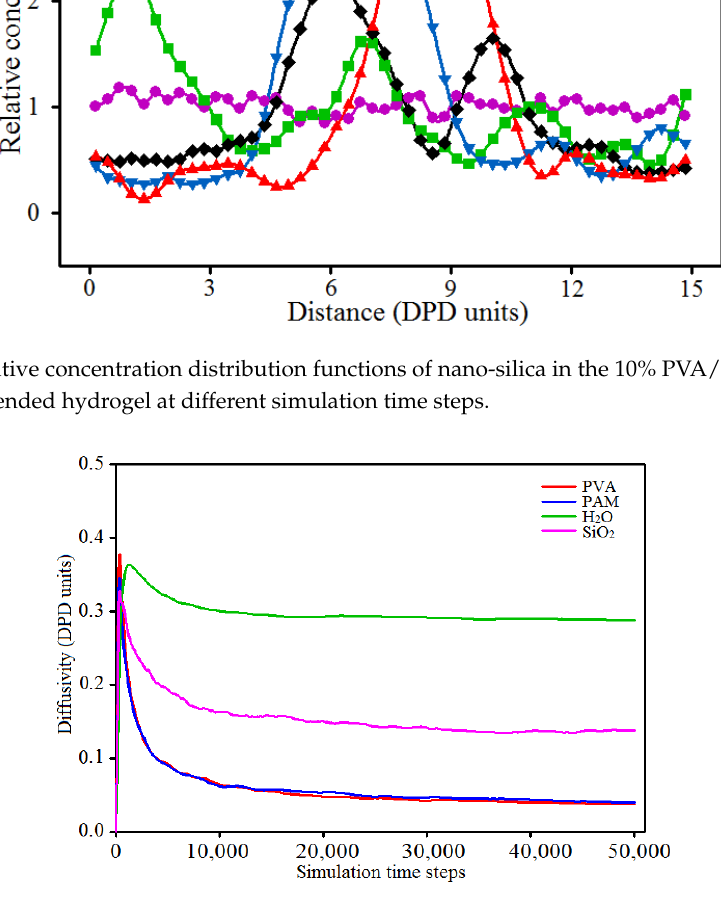
Figure 5. Curves of bead diffusion coefficients in the 10% PVA/10% PAM/2% nano-silica blended hydrogel system versus the simulation time steps.